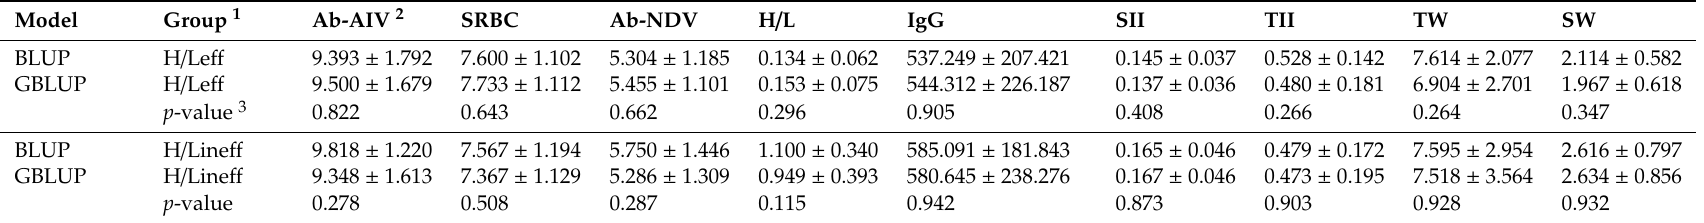
Table 6. Mean and standard deviation of breeding values of various traits predicted from the two methods for birds with low or high H / L.